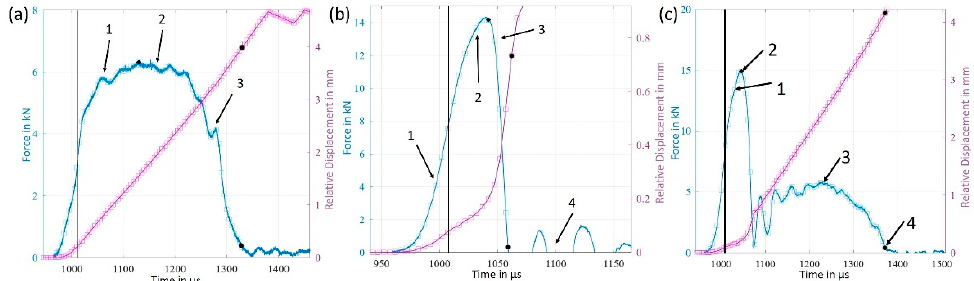
Figure 7. Force–time recordings for the multi-material high-rate tests on ( a ) bolted joints, ( b ) bonded